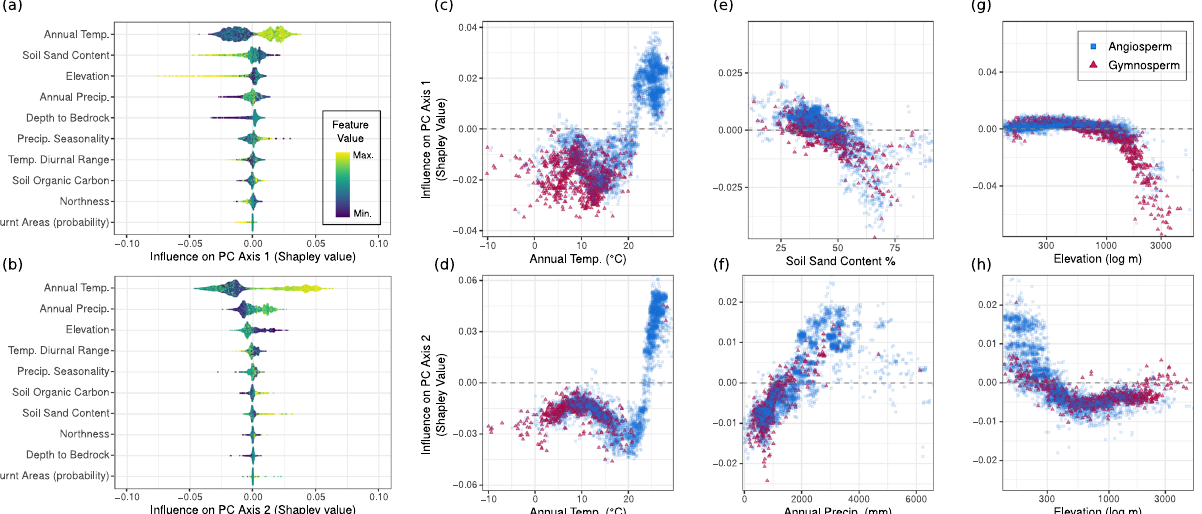
Fig. 3 The relationship between environmental variables and trait axes. a , b The relative in fl uence of the environmental variables on the two dominant PC axes. The ten variables are sorted by overall variable importance in the models (see Methods). Yellow points are observations which have high values of that environmental variable; blue values are the lowest. Points to the right of zero indicate a positive in fl uence on the PC axis; points to the left indicate a negative in fl uence (see also Supplementary Figs. 17, 18). c – h The relationships between environmental variables and PC axis values for the three variables in a with the strongest in fl uence. Values above zero show a positive in fl uence on PC axis values; values less than zero indicate a negative in fl